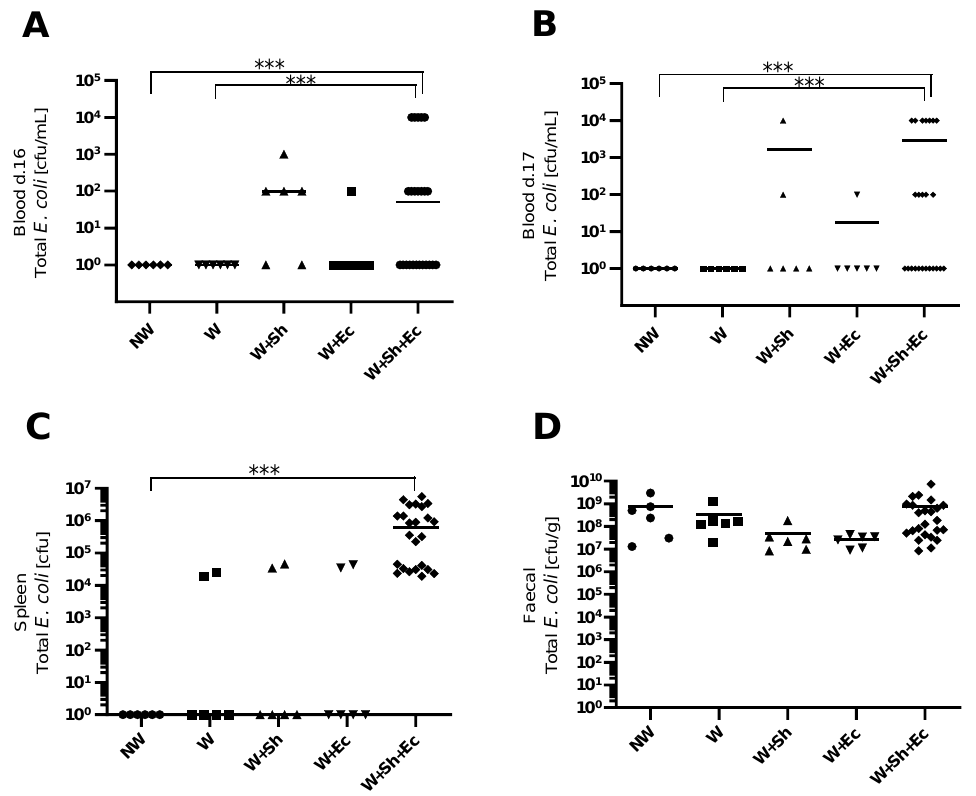
Figure 2. Population numbers of total E. coli in blood d. 16 ( A ), blood d. 17 ( B ), spleen ( C ) and feces ( D ). *** p < 0.01. NW-non-weaned control group, W-weaned group, W+Sh-weaned pups with intraperitoneal administration of Staphylococcus haemolyticus 186, W+Ec-weaned pups with oral administration of Escherichia coli 3A/1, W+Sh+Ec-target model group weaned with administration of both intraperitoneal S. haemolyticus 186 and oral E. coli